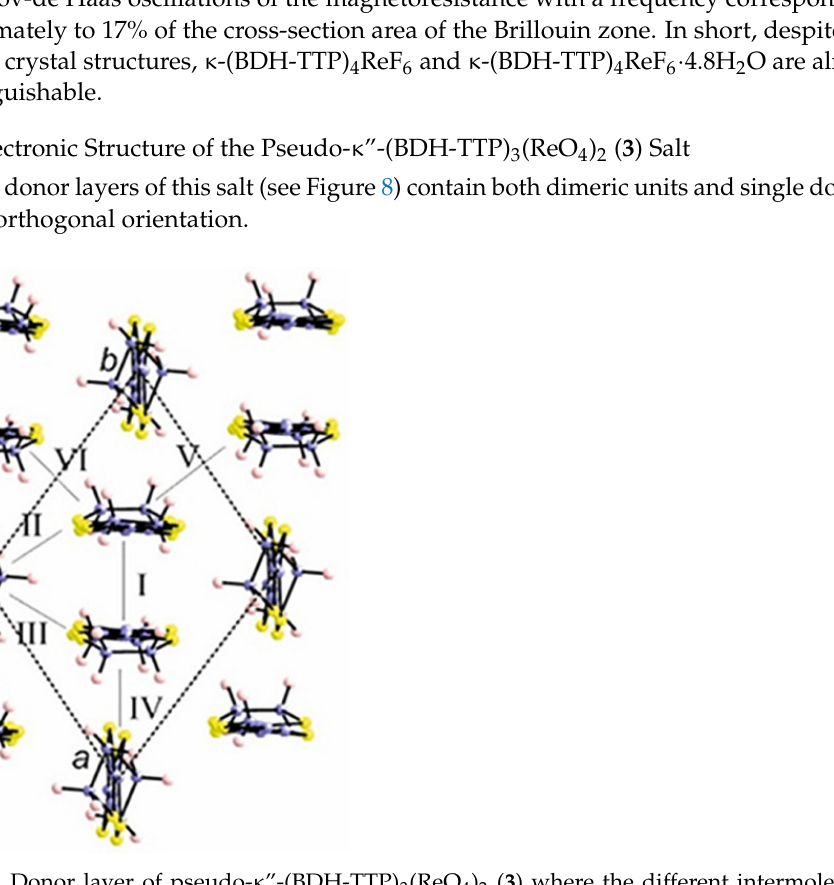
Figure 8. Donor layer of pseudo- κ″ -(BDH-TTP) 3 (ReO 4 ) 2 ( 3 ) where the different intermolecular in- interactions are teractions are labelled.